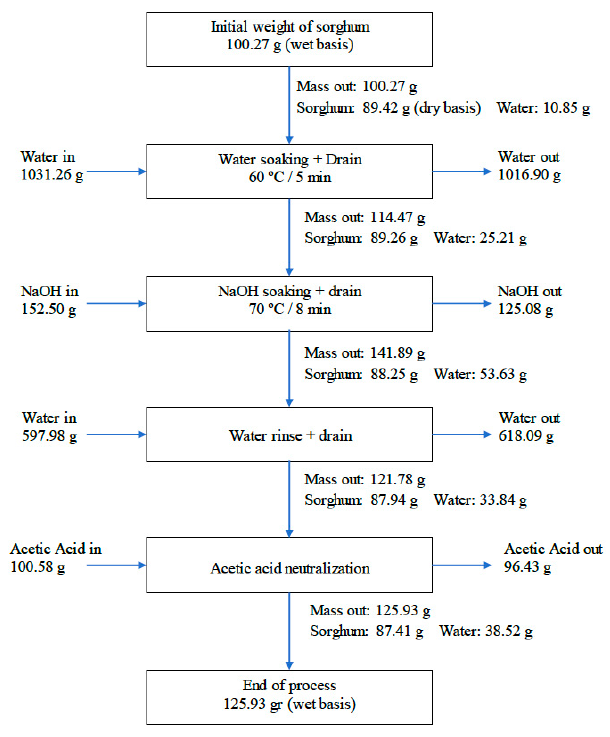
Figure 1. Alkaline tannin removal mass